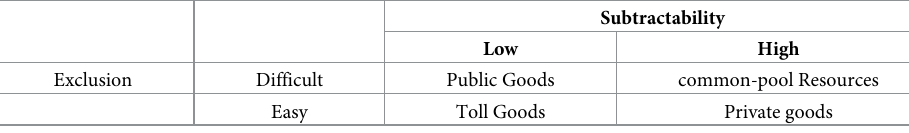
Table 1. A classification of goods (Ostrom et al., 1992,